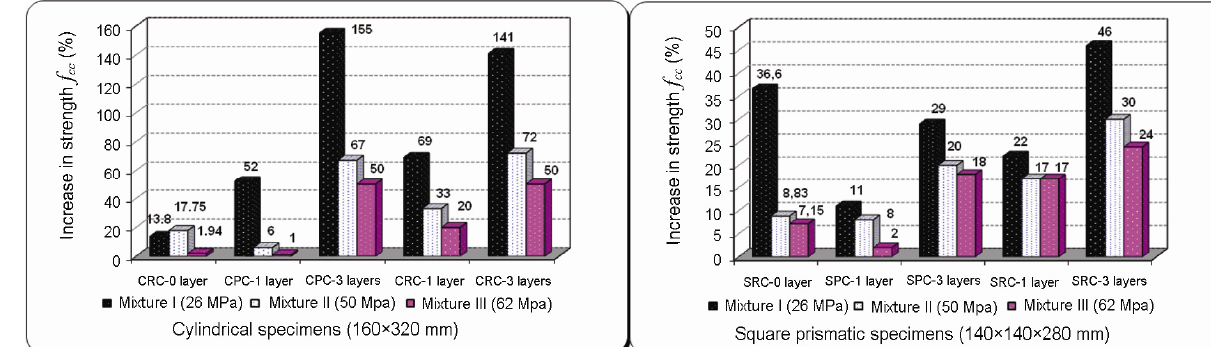
Fig. 6. Effect of unconfined strength of concrete on peak stresses